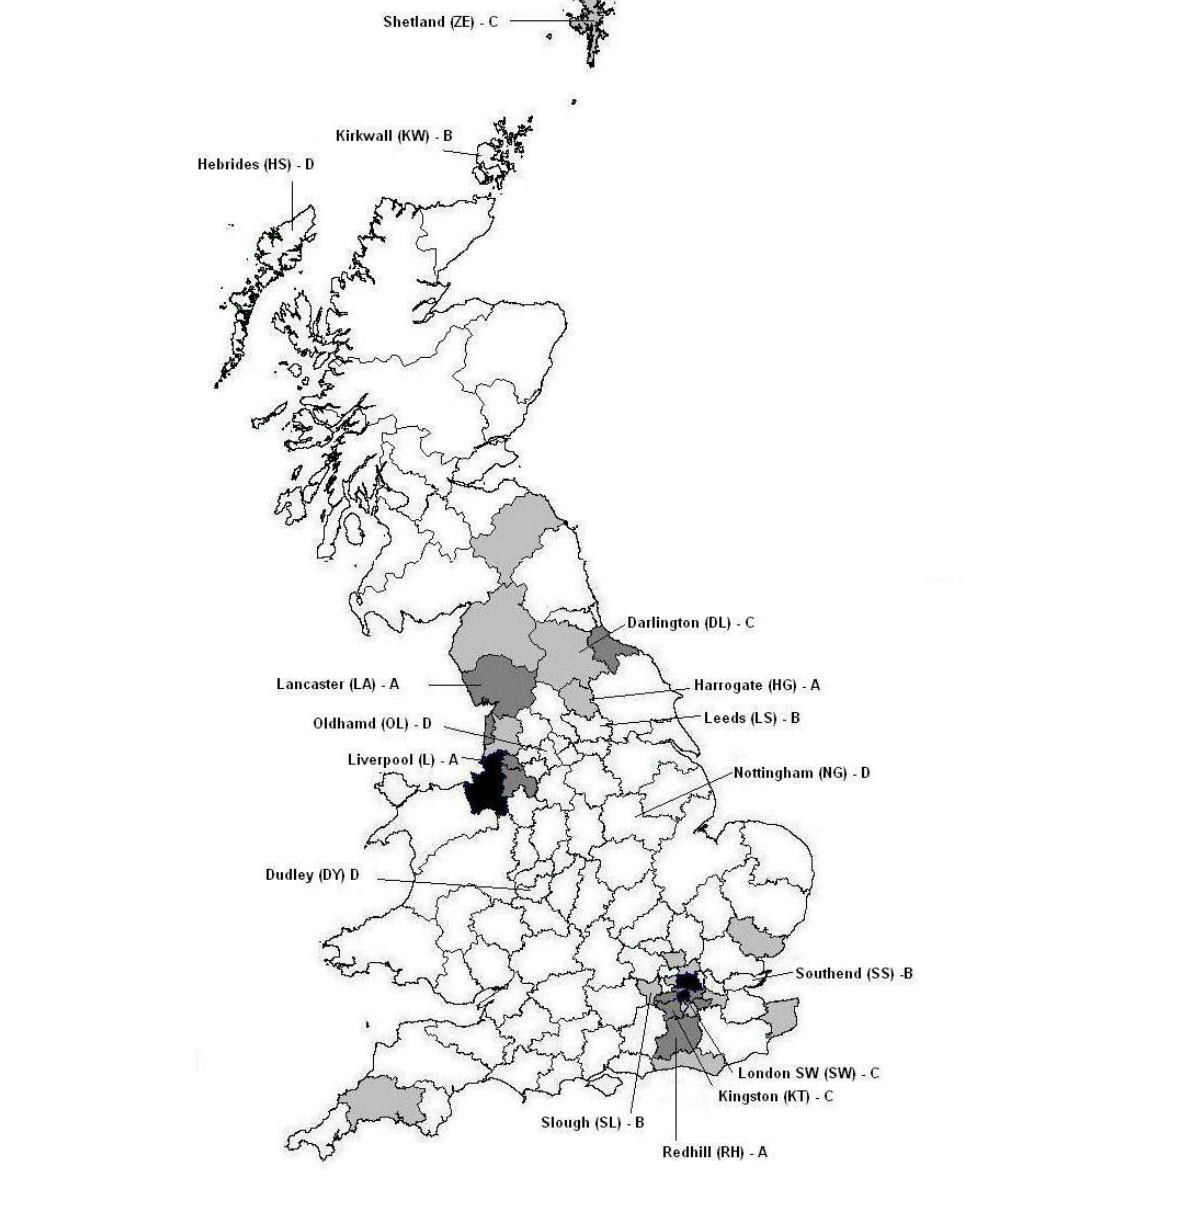
Figure 3. Location-targeted Google ad. NHS = UK National Health